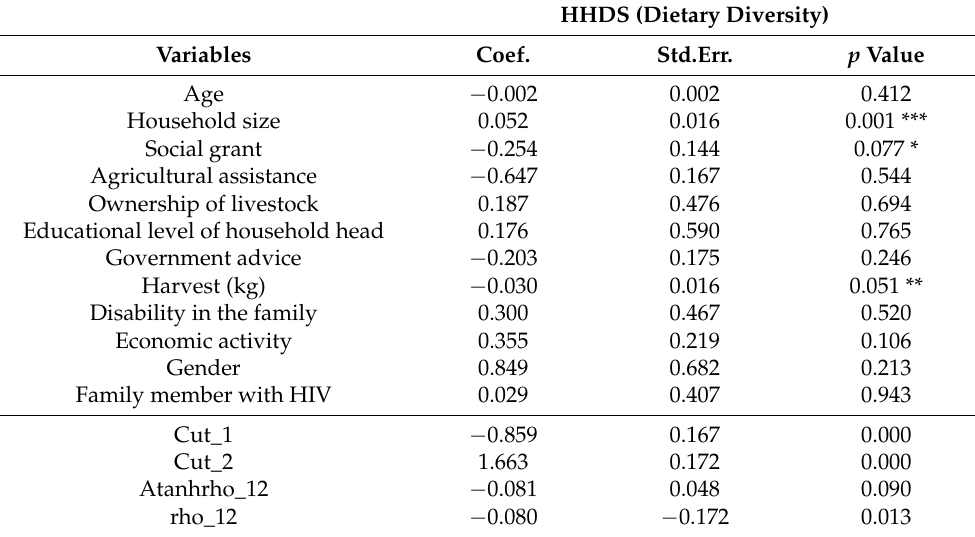
Table 3. Determinants of crop productivity on dietary diversity using Conditional Mixed Process (CMP)